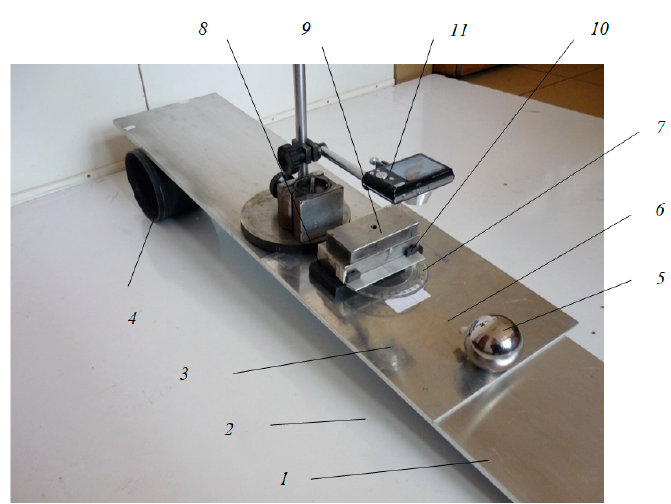
Figure 9. Scheme for measurement of precession angle. Materials 2020 , 13 , x FOR PEER REVIEW